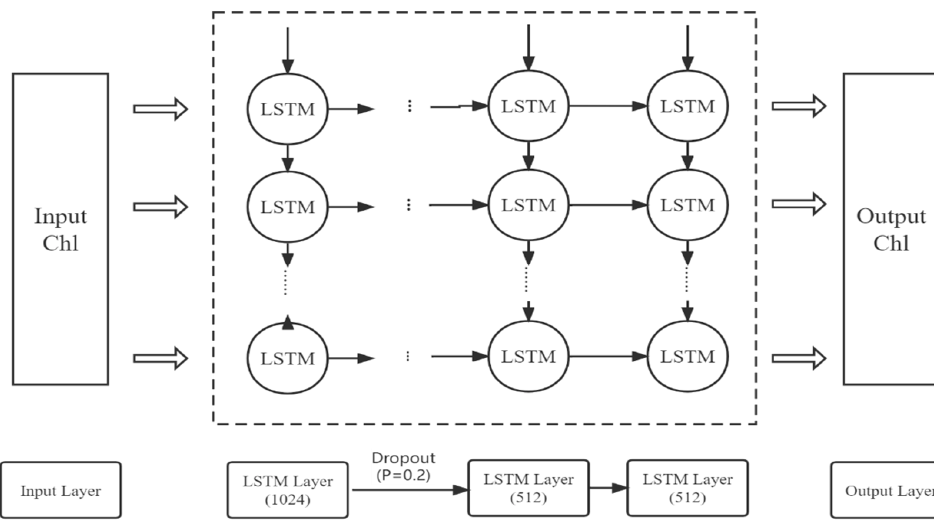
Figure 2. Architecture of the LSTM model for Chl-a forecasts.